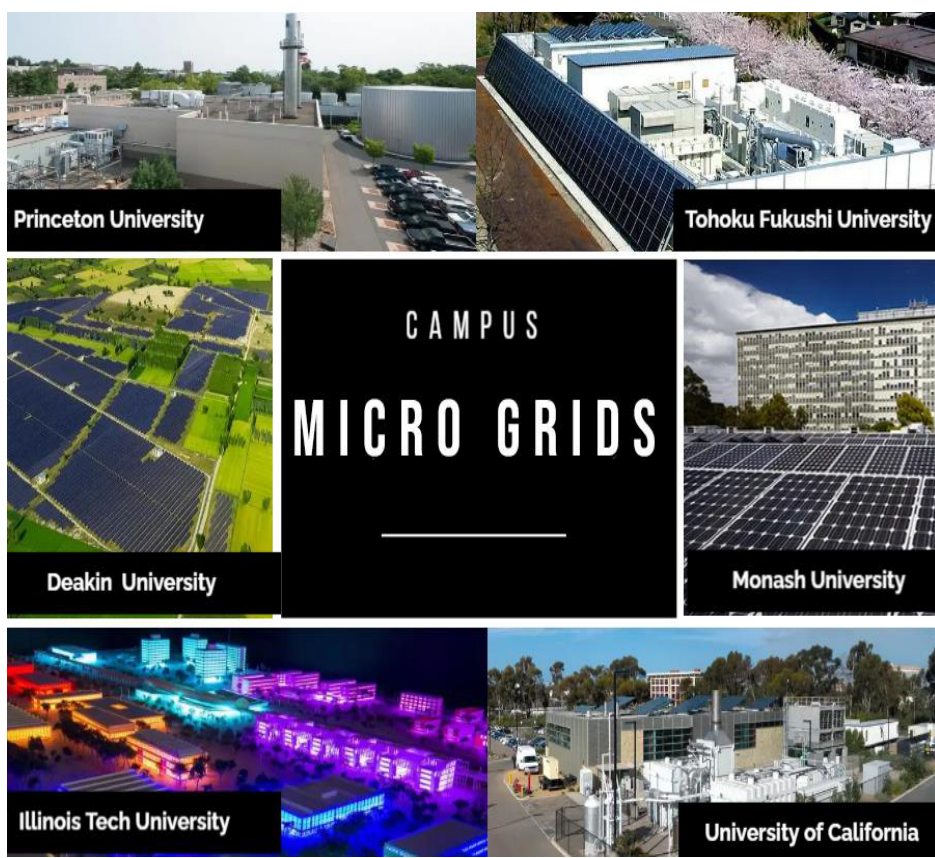
Figure 3. Campus microgrids at different universities.